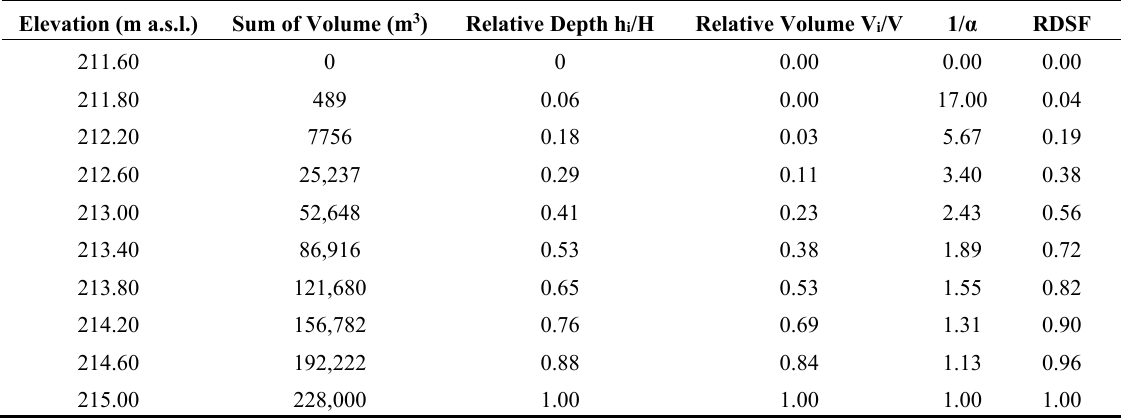
Table 5. Relative Depth Shape Function for different elevations from reservoir bed established for Zes ł awice-1